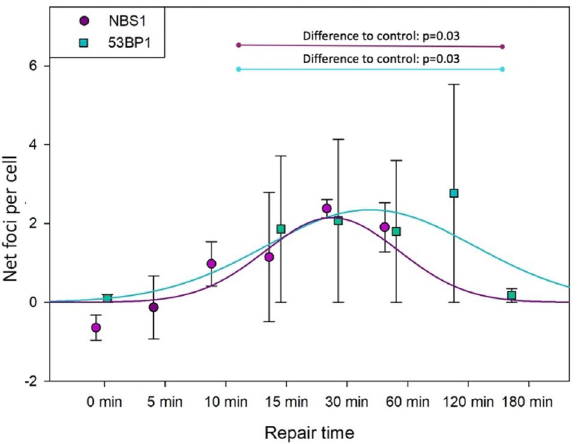
Figure 3. Repair at 0.8 °C: kinetics of NBS1 and 53BP1 foci formation and decay in U2OS cells exposed to 2 Gy of gamma radiation at 0.8 °C and allowed to repair at 0.8 °C. Shown are focus frequencies following subtraction of control values. Time scale is not proportional. See Fig. 1A for an explanation of the treatment groups. Blue dashed line represents the control value. Error bars represent standard deviations from 3 experiments. One way ANOVA on ranks was performed for data points corresponding to 10–180